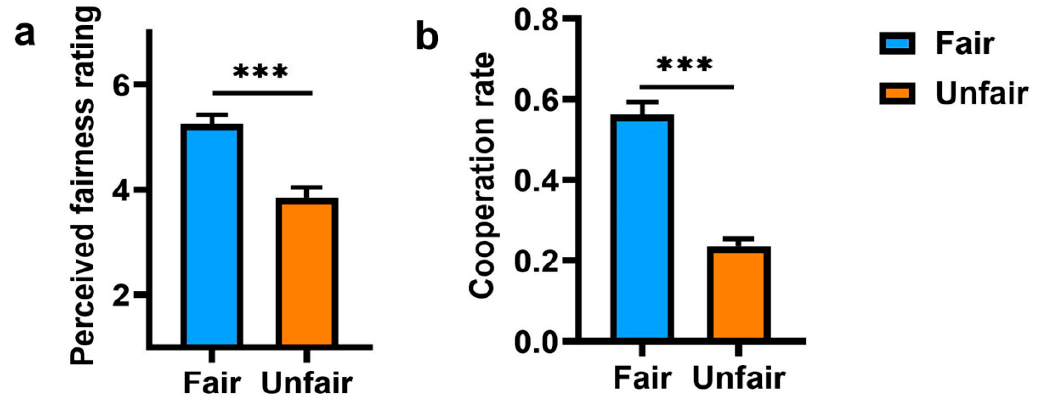
Figure 2. Results from Exp. 1. ( a ) Mean perceived fairness rating in fair and unfair conditions; ( b ) mean cooperation in fair and unfair conditions, presented separately for participants randomly assigned to players whose choices were either 80% cooperation or 80% defection. Error bars indicate standard error. ***: p < 0.001.